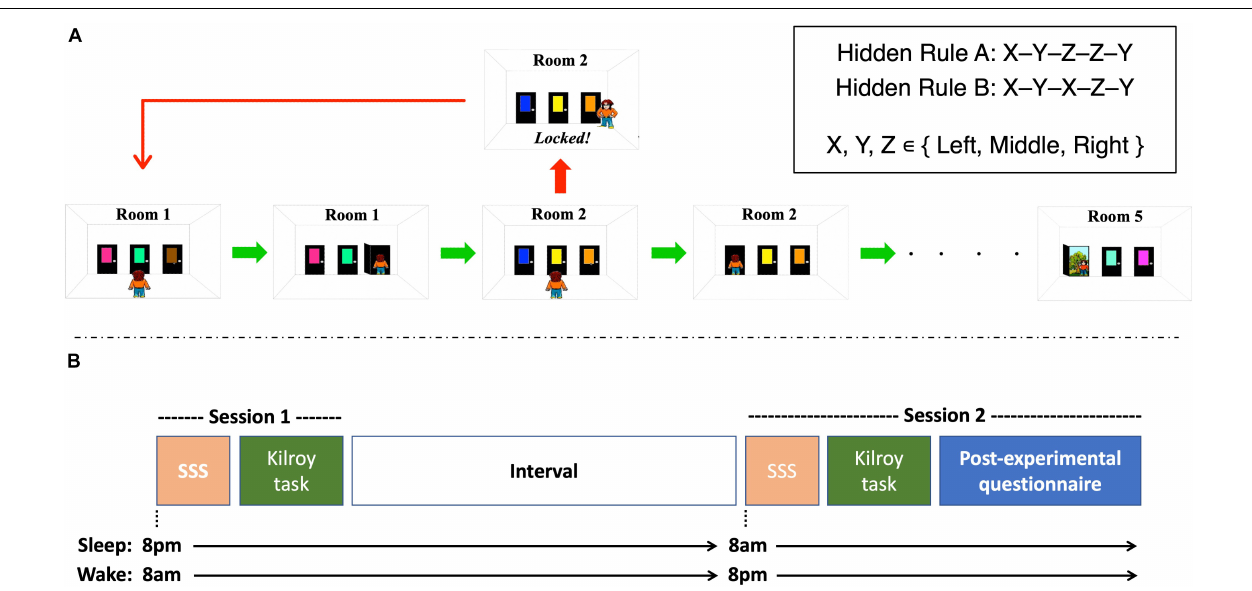
FIGURE 1 | Details on the behavioral experiment. (A) Example of a trial in the sequential learning task. Participants guided a character throughout five consecutive rooms, each containing three colored doors. One door led to the next room (or to the exit in the 5th room) and the other two were locked. Choosing a locked door forced participants to start over in room 1. A hidden rule governed the locations of some of the correct doors, the discovery of which allowed choosing the correct door in some of the rooms immediately rather than by trial and error. Two rules were employed, with each participant exposed to only one of the rules. (B) Experimental Design. Participants were administered 2 sessions with an interval in between. The sleep group underwent session 1 at the evening and session 2 the following morning and allowed to sleep regularly in between. The wake group underwent session 1 at the morning and session 2 at the evening with no intervening sleep. In each session, participant completed the Stanford Sleepiness Scale (SSS), and 40 trials of the experimental task. In session 2 participants also completed a post-experimental questionnaire examining their conscious awareness of the hidden